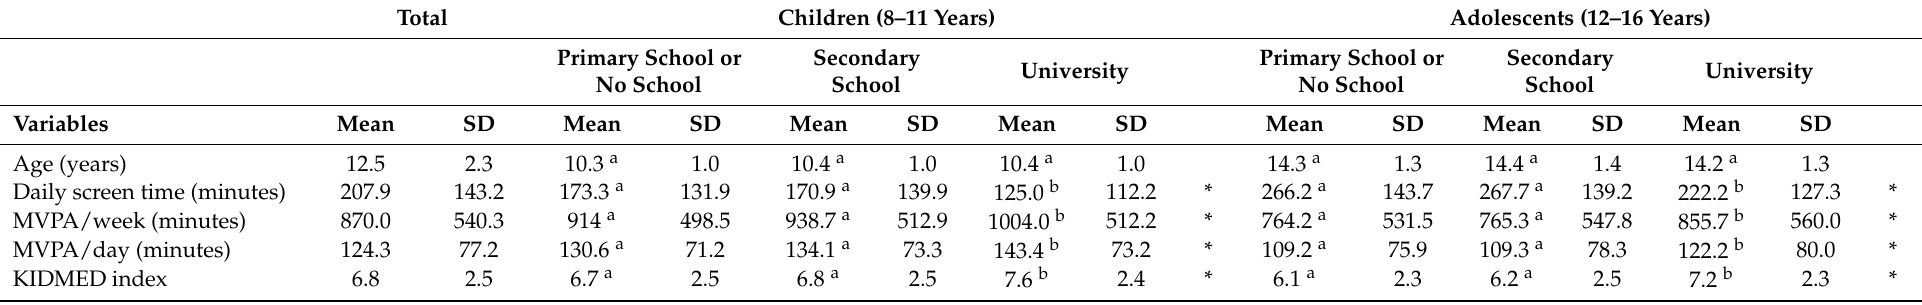
Table 2. Characteristics of study participants: age, screen time, physical activity, and KIDMED index for the total study population and according to parents’ education level.